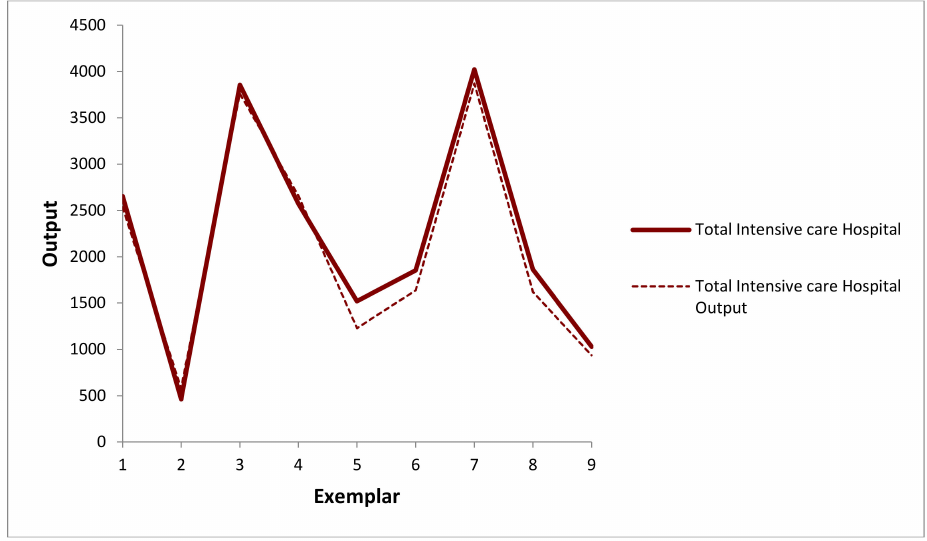
Figure A3. Predicted values by ANN algorithm vs. cross validation data